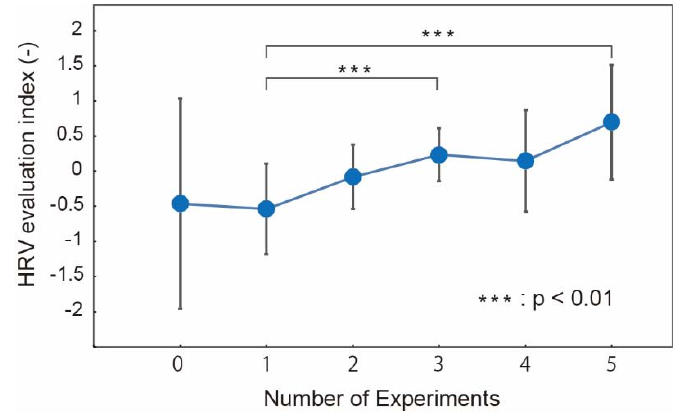
Figure 7. Normalized heart rate variance (HRV) with respect to the number of U–K tests ( n = 16). “ p ” represents the p -value in statistics hypothesis testing.